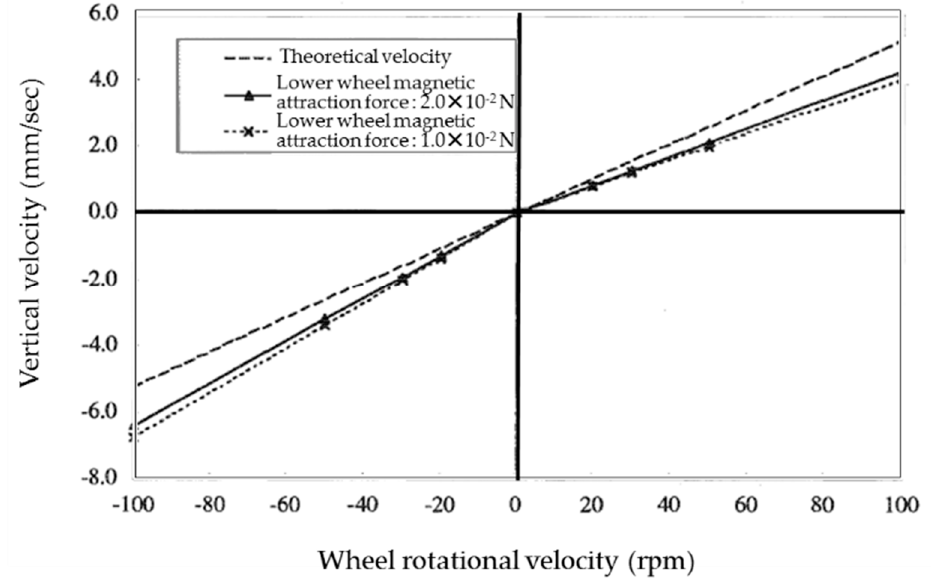
Figure 10. Relationship between the vertical velocity and wheel rotational velocity. Due to the impact of gravity, the observed vertical velocity was lower than the theoretical velocity when climbing and higher than the theoretical velocity when descending.